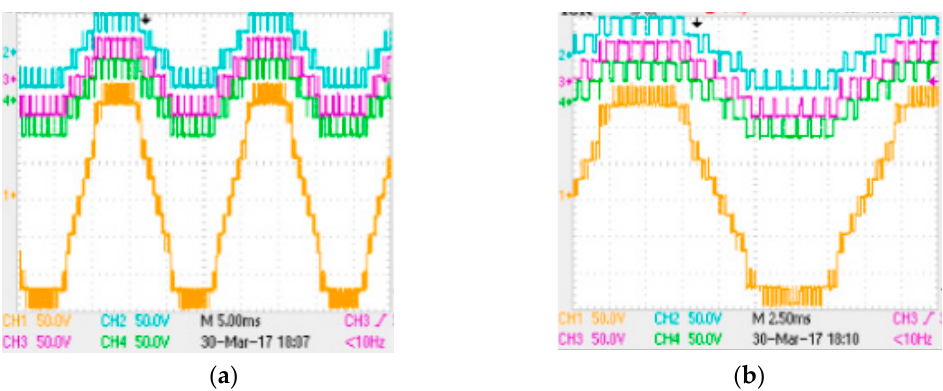
Figure 19. The output voltage waves of the three-model 3L-NPC cascaded converter. ( a ) The relationship of the output voltage waves; ( b ) the output voltage waves in about one period (CH1: the output voltage of cascaded converter; CH2: the voltage of the inverter 1; CH3: the voltage of the inverter 2; CH4: the voltage of the inverter 3).